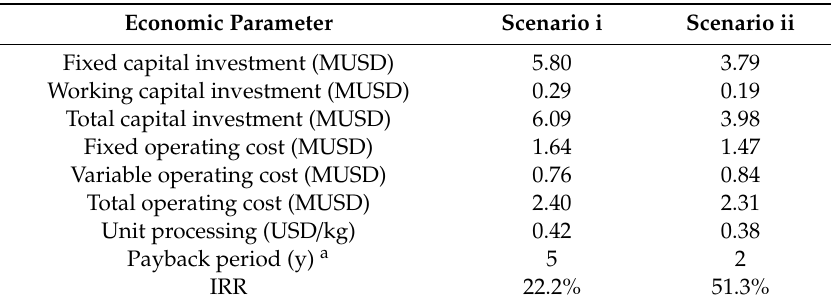
Table 5. Outcome of the economic assessment.